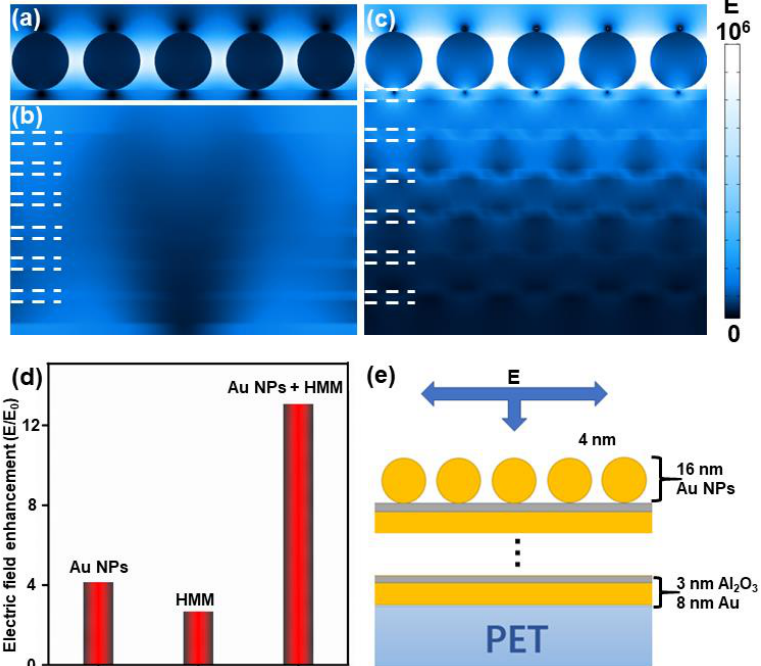
Figure 3. The simulation of y–z views of electric field distributions for ( a ) single Au-NP layer, ( b ) the hyperbolic metamaterial (HMM) consisting of six bilayers with 8 nm Au and 3 nm Al 2 O 3 , and ( c ) the combination of the Au-NP layer and HMM. ( d ) A histogram drawing a comparison of the electric field enhancement ( E / E 0 ) among the Au NPs, HMM and Au NPs + HMM composite structure. ( e ) The simulation setup of the composite structure substrate.